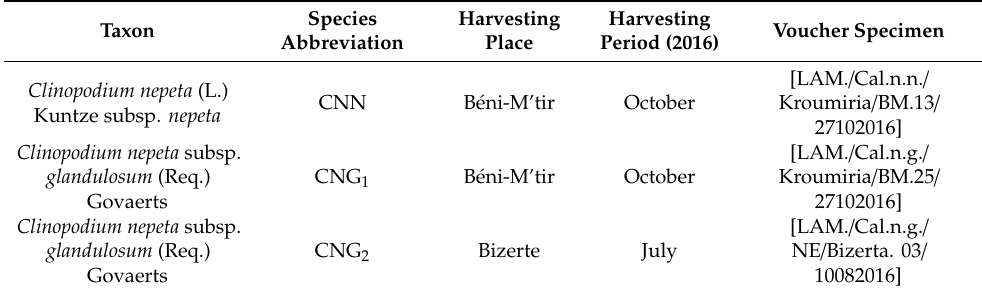
Table 1. Locality / Harvesting place, harvesting period and voucher specimen reference of both Clinopodium nepeta subspecies.